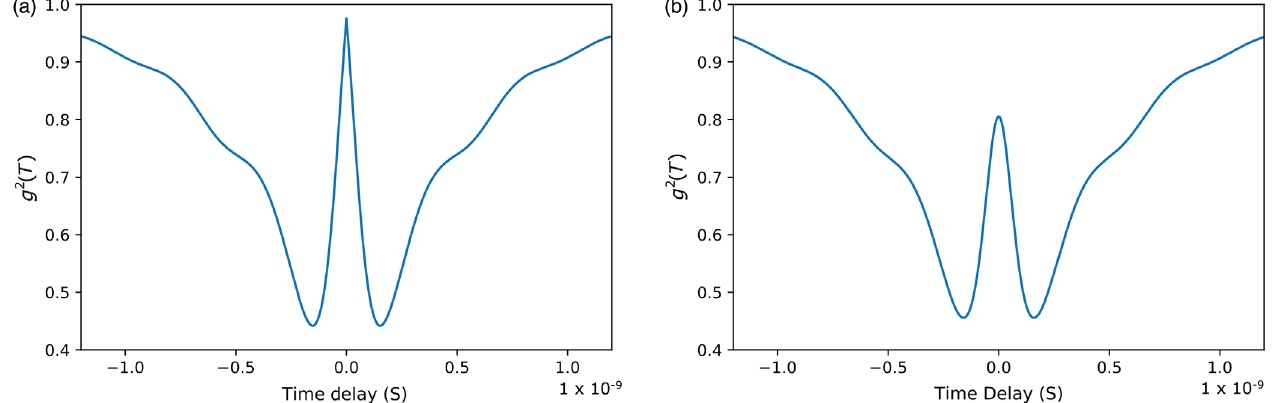
FIG. 7. Simulated photon correlation function for two emitters on resonance without (a) and with (b) inclusion of electronic jitter measured in the